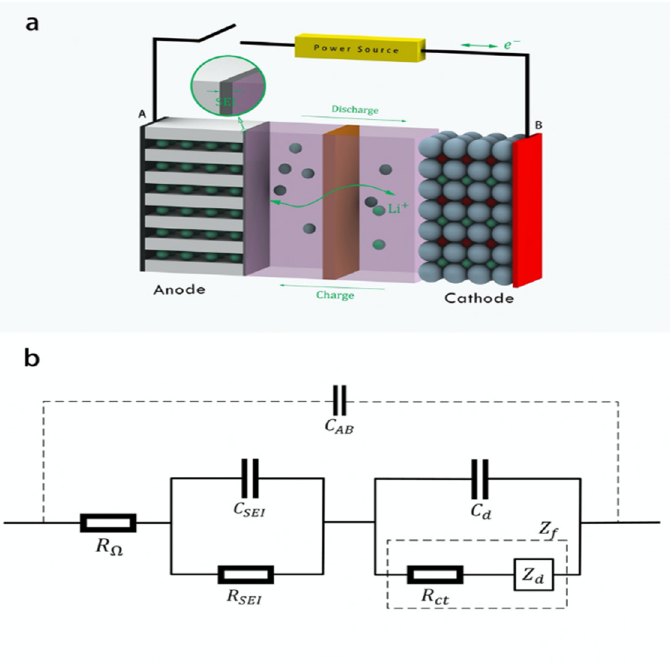
Figure 1. Lithium-ion battery diagram: ( a ) Battery structure. ( b ) Battery equivalent